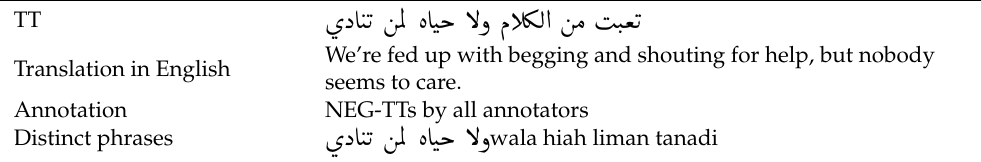
Table 13. TT containing a